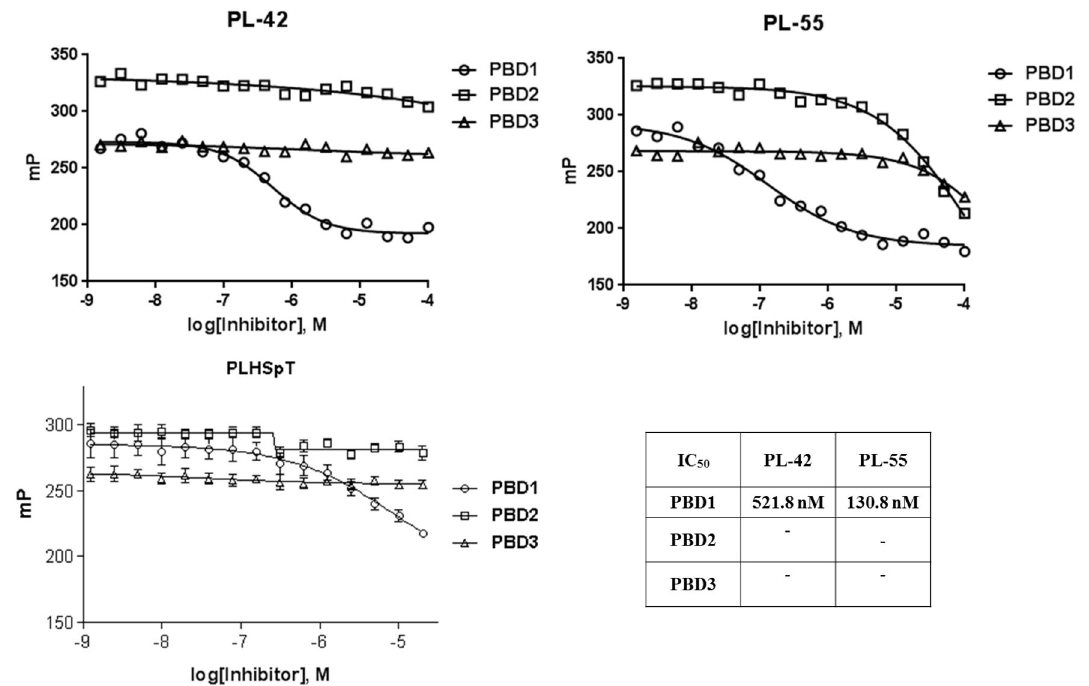
Figure 8. Comparison of fluorescence polarization–based assays showing the selective inhibition of Plk1 PBD over Plk2 and 3 PBDs by PL-42 and PL-55. doi: